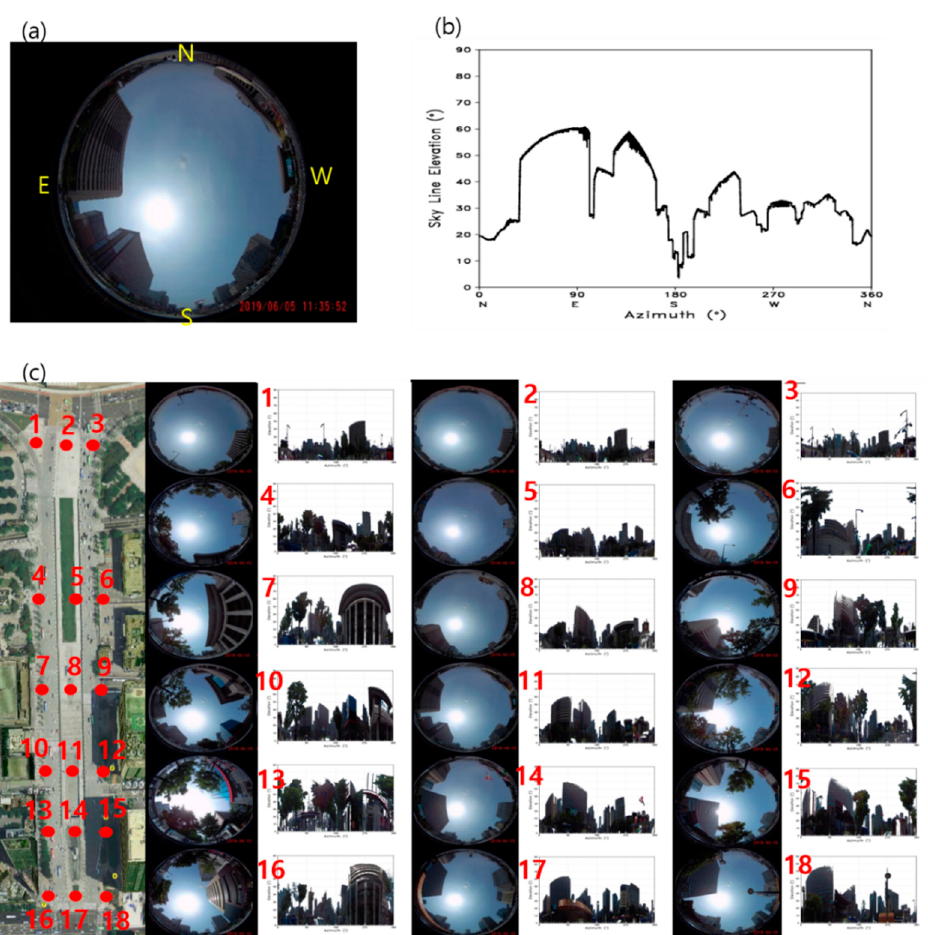
Figure 6. ( a ) A photo taken of the zenith by a fish-eye lens camera, ( b ) sky line elevation with respect to the azimuth angle, and ( c ) sky views and sky line elevations at 18 selected points in the campaign domain.